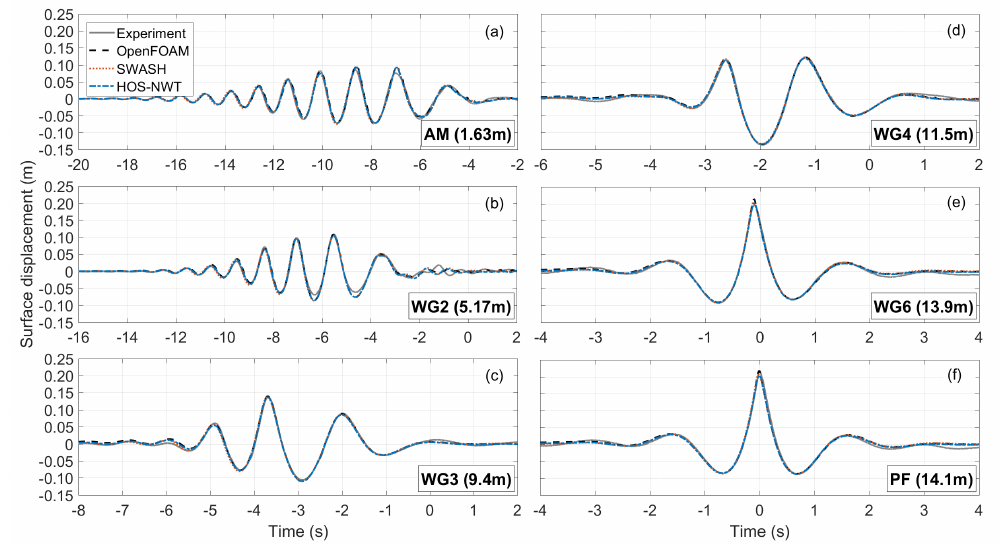
Figure 12. Comparison of the measured surface elevation between the numerical models and the experiment at different locations ( a – f ).